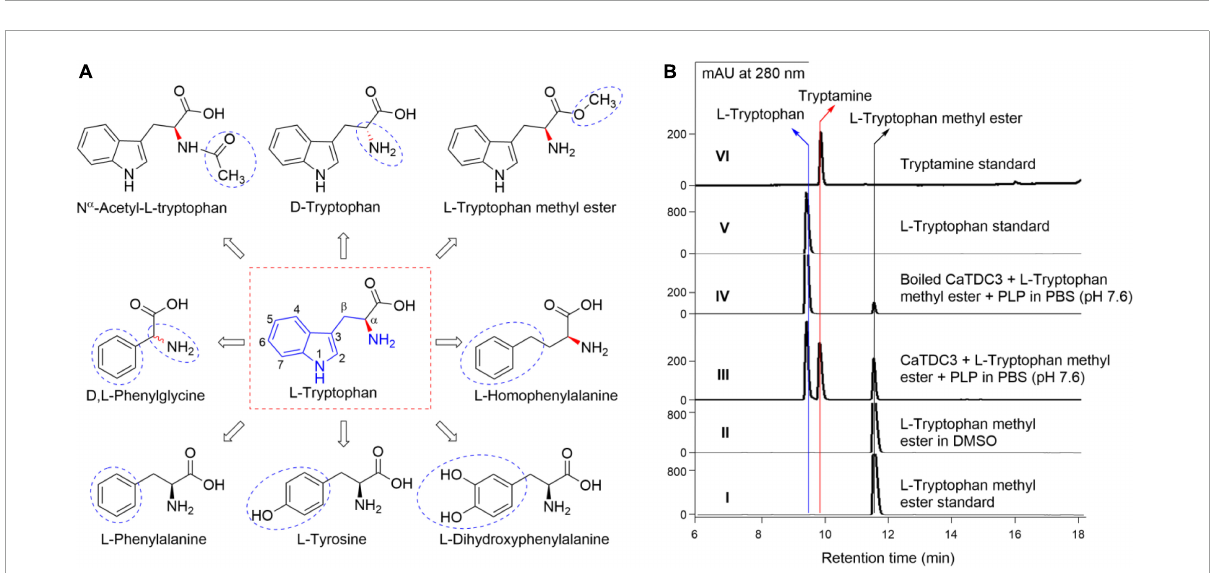
FIGURE7 Basic structure requirements of substrate for CaTDC3-catalyzed decarboxylation reaction. Chemical structures of L-tryptophan analogs tested in the present work (A) . (B) HPLC-DAD analyses of the decarboxylation reaction in PBS buffer catalyzed by CaTDC3 (panel III) and boiled CaTDC3 (panel IV), respectively. Panels I, V, and VI are the HPLC-DAD traces of authentic L-tryptophan methyl ester, L-tryptophan, and tryptamine, respectively. Panel II is the HPLC-DAD trace of L-tryptophan methyl ester dissolved in DMSO. The blue cycles indicated the groups different from that of